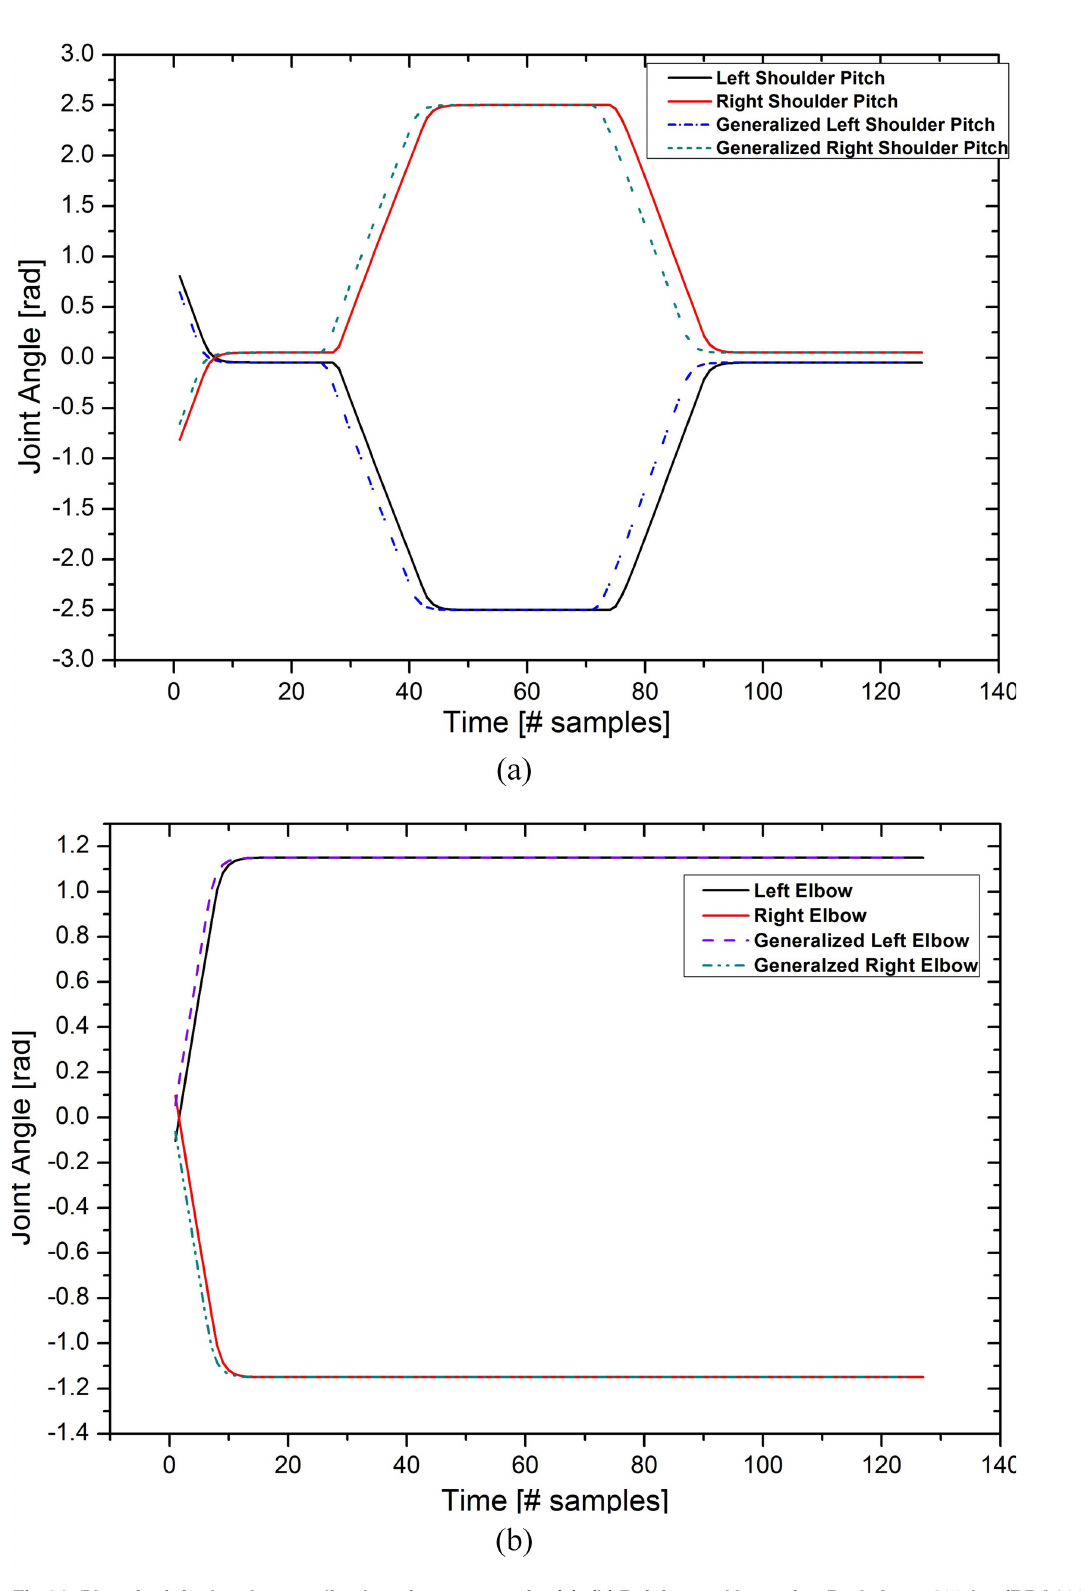
Fig 14. Plot of original and generalized motion patterns for (a) – (b) Raising and Lowering Both Arms 180deg (RBA180 – LBA180).